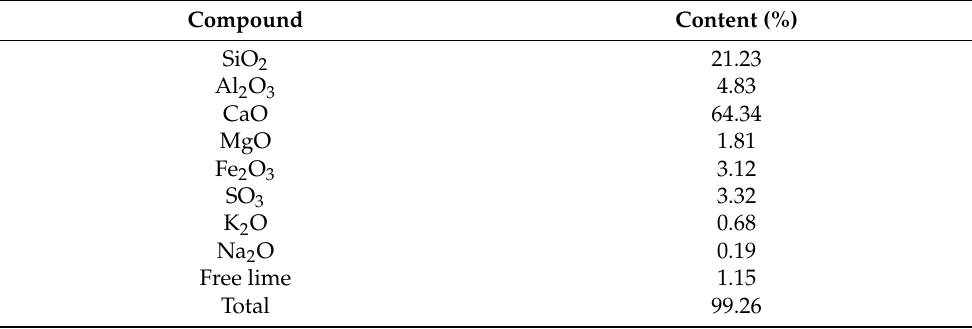
Table 1. Composition and properties of the P I 42.5